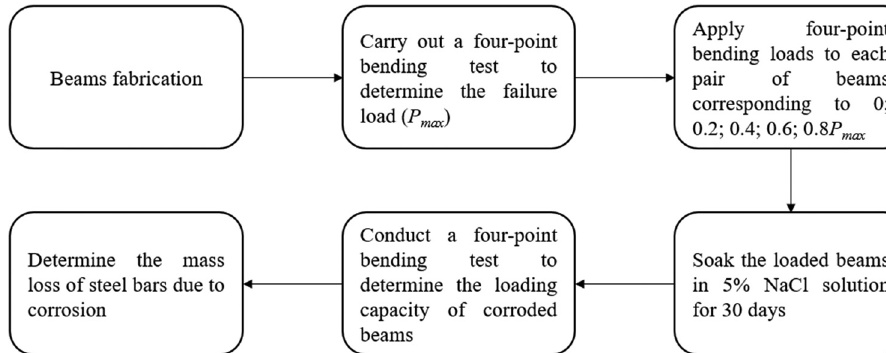
Figure 3: Flow chart of the experimental steps.